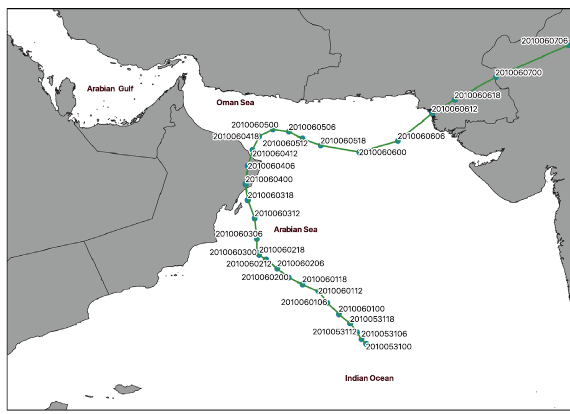
Figure 9: The best track of the TC “Phet” (source: JTWC).